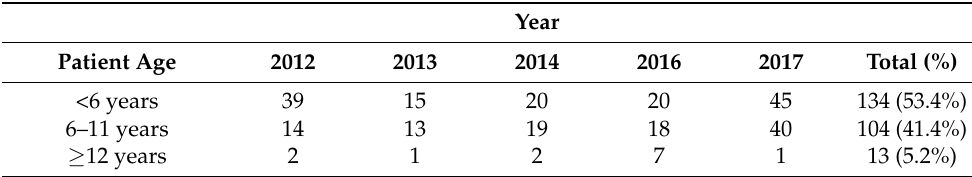
Figure 1. ( a ) Graph showing the average gender distribution of referred patients over the 5-year period. ( b ) Chart representing the overall ethnicity of the referred GA/sedation patient population (%). Table 3. Age of referred patients by year. Table 3. Age of referred patients by year.